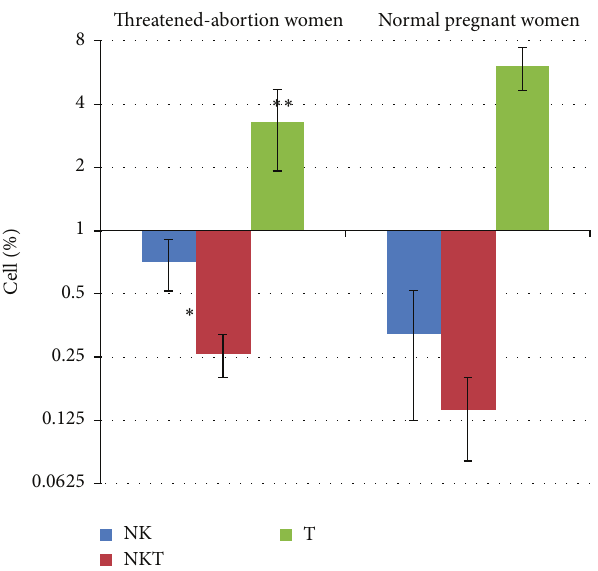
Figure 3: The comparison of relative expression of HLA-G1 and HLA-G5 isoforms in threatened-abortion women and control group (mean ±